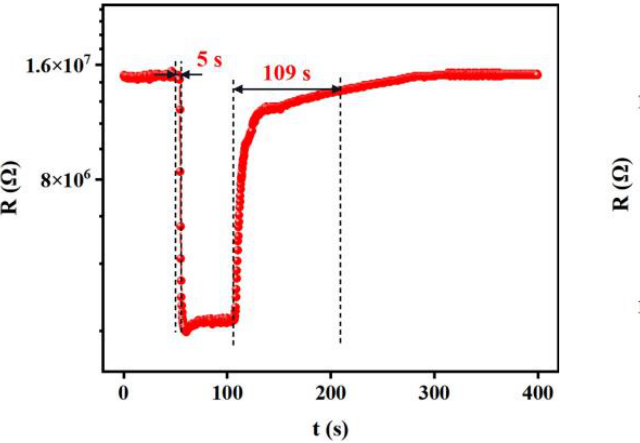
Figure 7. Gas-sensing response of Sn/SnO 2 sample to different ethanol concentrations at different operating temperatures.